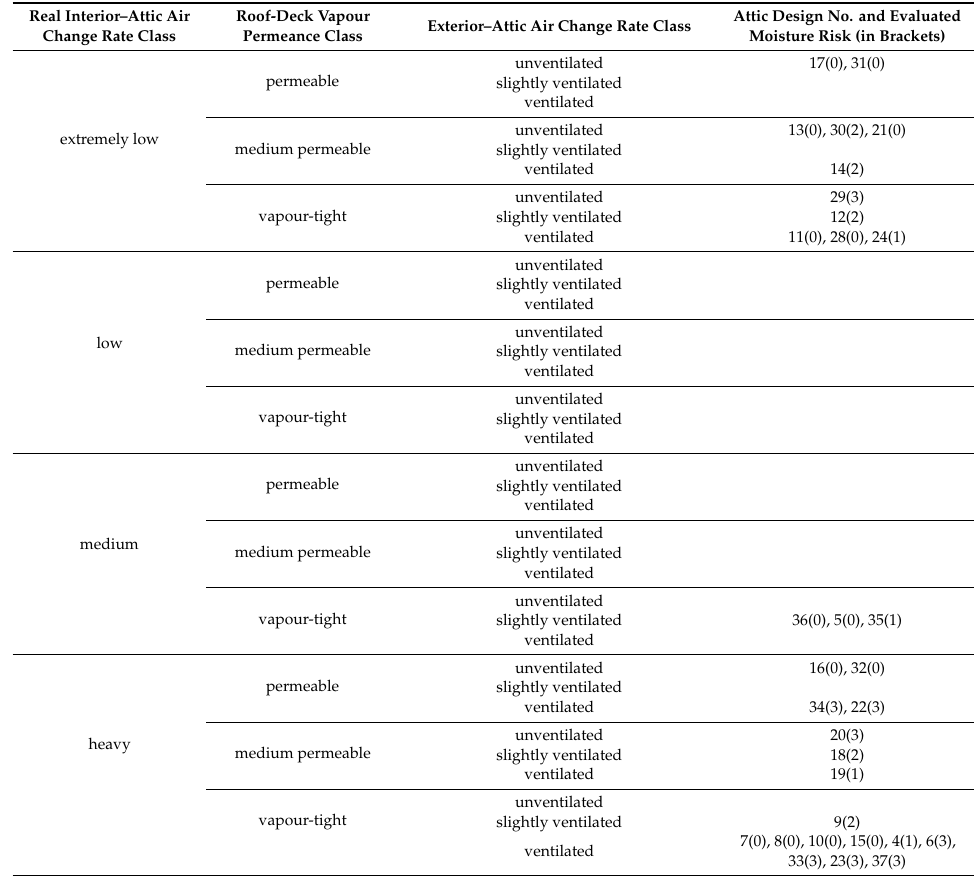
Table 6. Table of suggested attic design groups with the 31 main attic